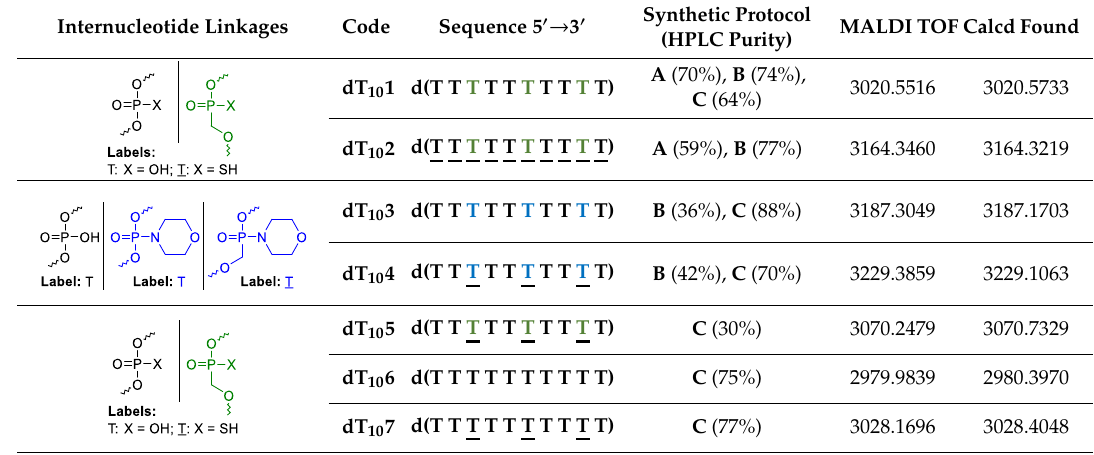
Table 2. Summary of model homo-oligothymidylates dT 10 1 – dT 10 7 .